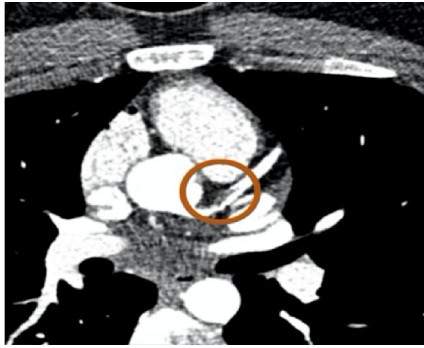
Figure 2: cCTA showing focal dissection in proximal LAD.